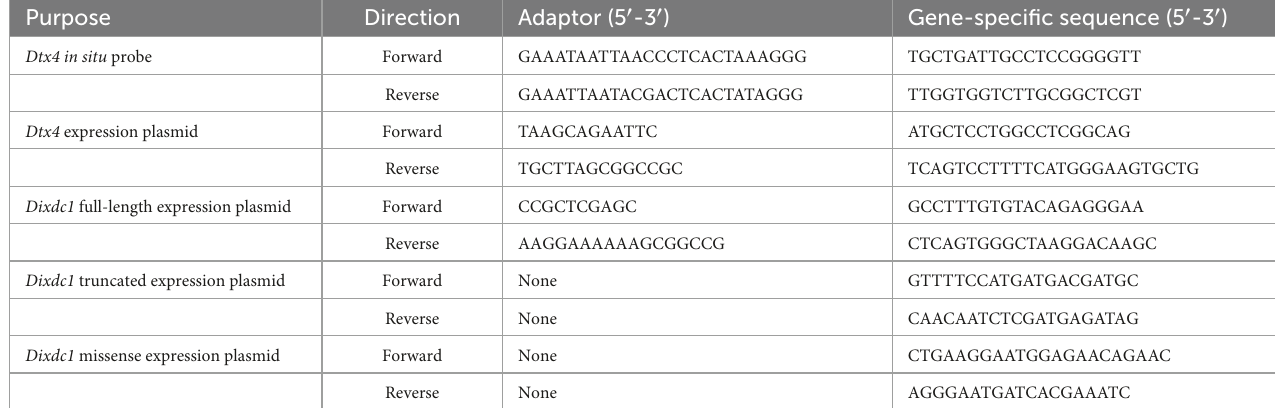
TABLE 2 Primers used for the development of molecular tools in this